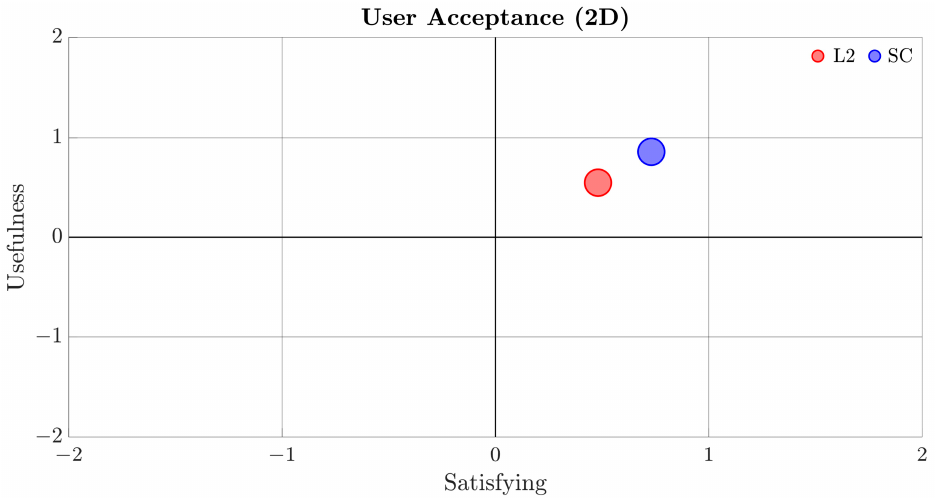
Figure 17. System Acceptance Scale results (Satisfying vs.